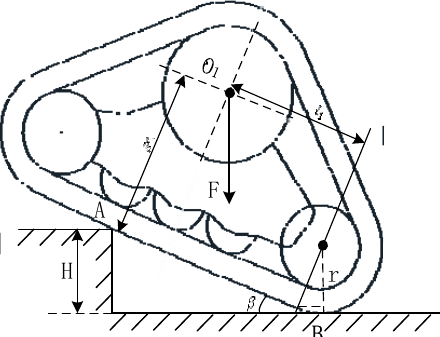
Figure 9. Schematic of triangular track crossing the ridge.